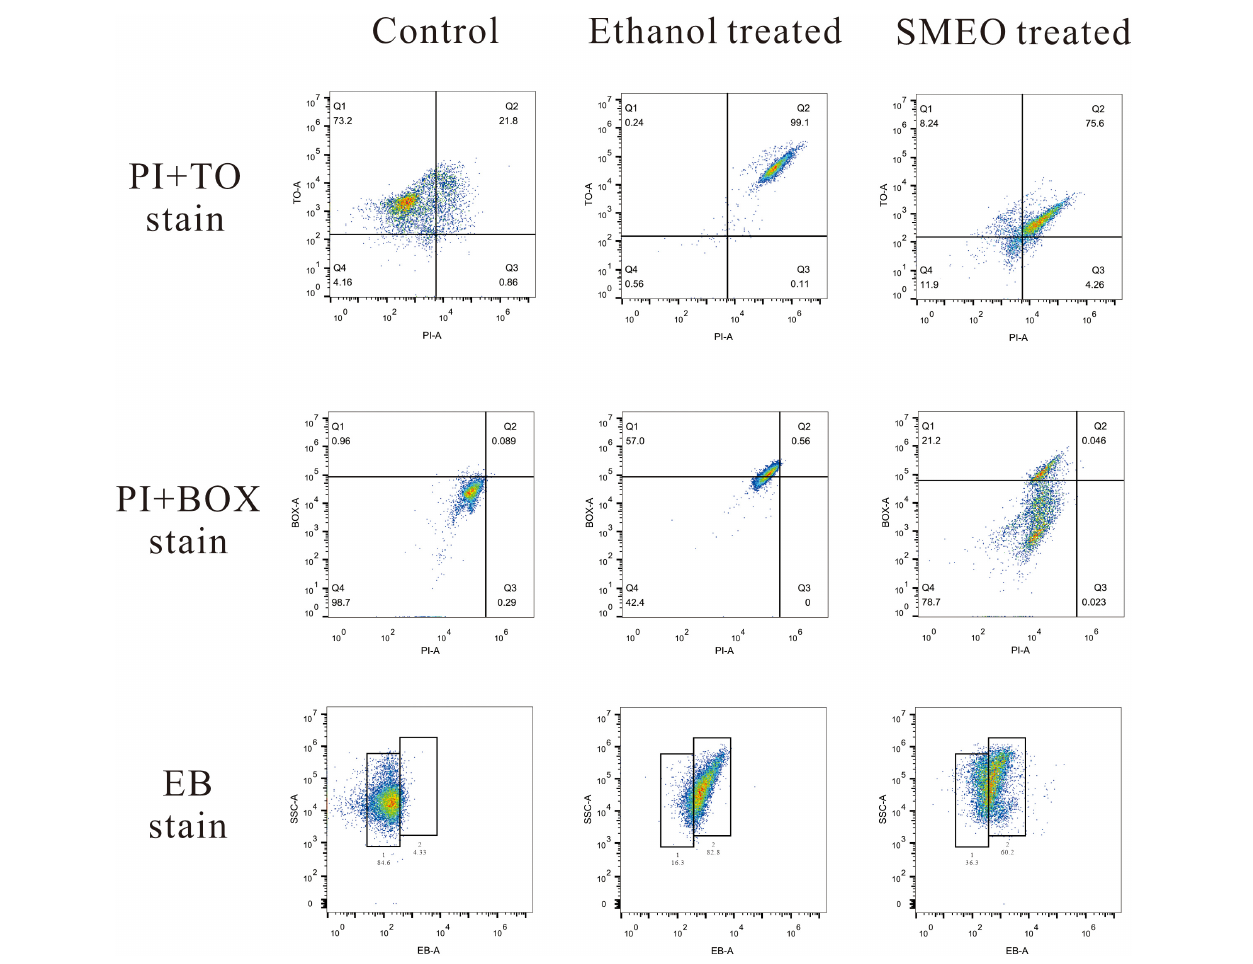
FIGURE 5 | Fluorescence density plots of A. hydrophila treated with ethanol, SMEO, and PBS (Control), stained with propidium iodide (PI) and thiazole orange (TO), PI and bis-1,3-dibutylbutyric acid (BOX) and ethidium bromide